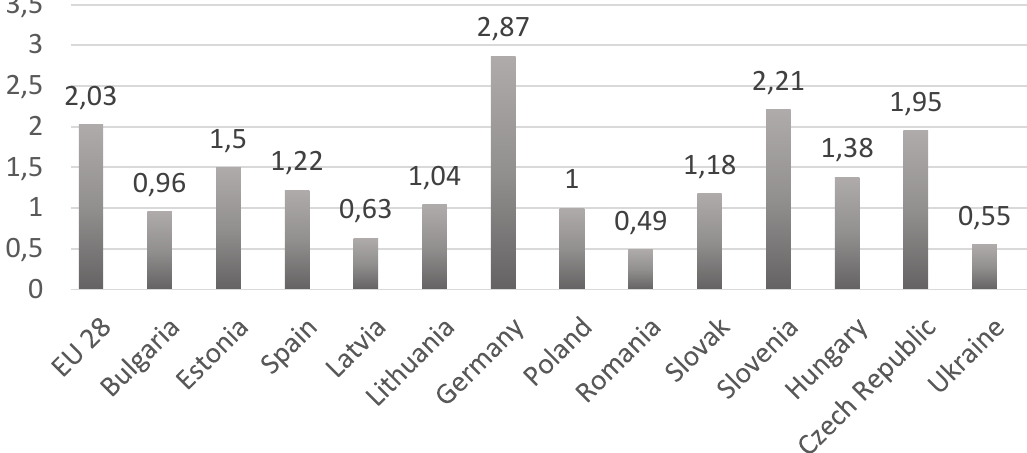
Source: Made by authors based on Державна служба статистики України [Derzhavna sluzhba statystyky Ukrainy] (